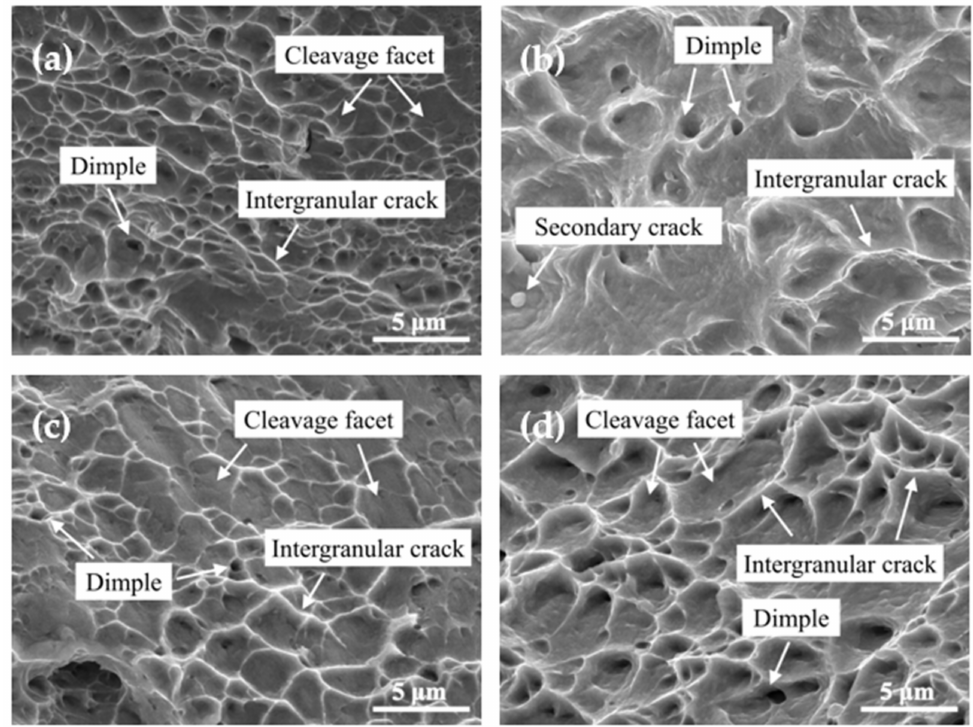
Figure 2. Tensile fracture morphologies of the alloys at different conditions. ( a ) C17200 in the unaged state; ( b ) QBe2.0 in the unaged state; ( c ) peak aging of C17200; ( d ) peak aging of